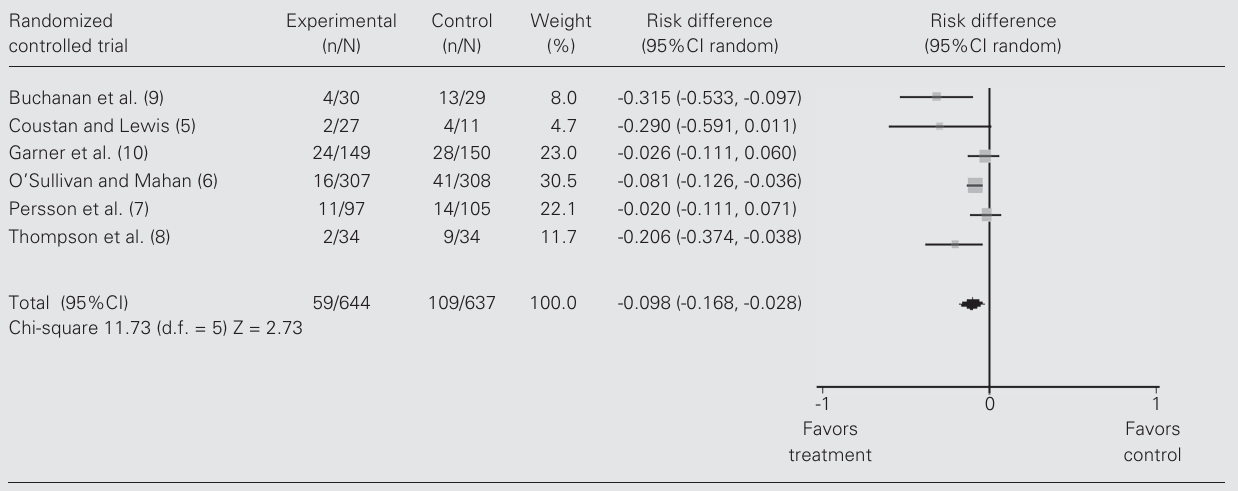
Table 2. Meta-analysis of effects of insulin treatment on the incidence of macrosomia in the included randomized controlled trials. Randomized Experimental Control Weight Risk difference Risk difference